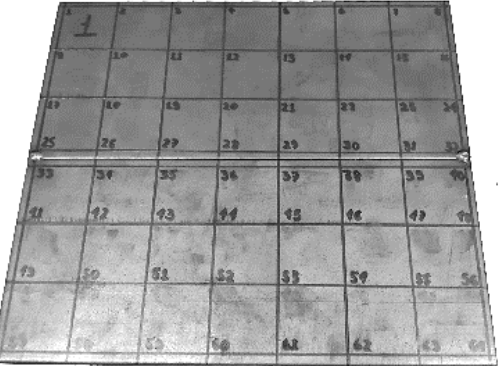
Figure 6. Steel sheets samples for welding process. Table 5. Parameters used in welding of top